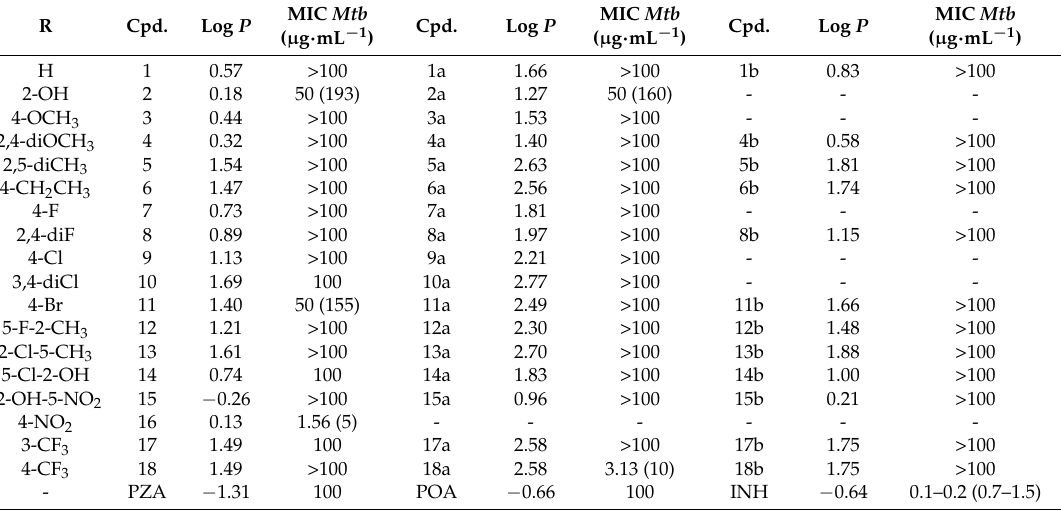
Table 1. Prepared compounds with lipophilicity parameter log P and antimycobacterial activity against Mtb in µ g · mL − 1 and in µ M in